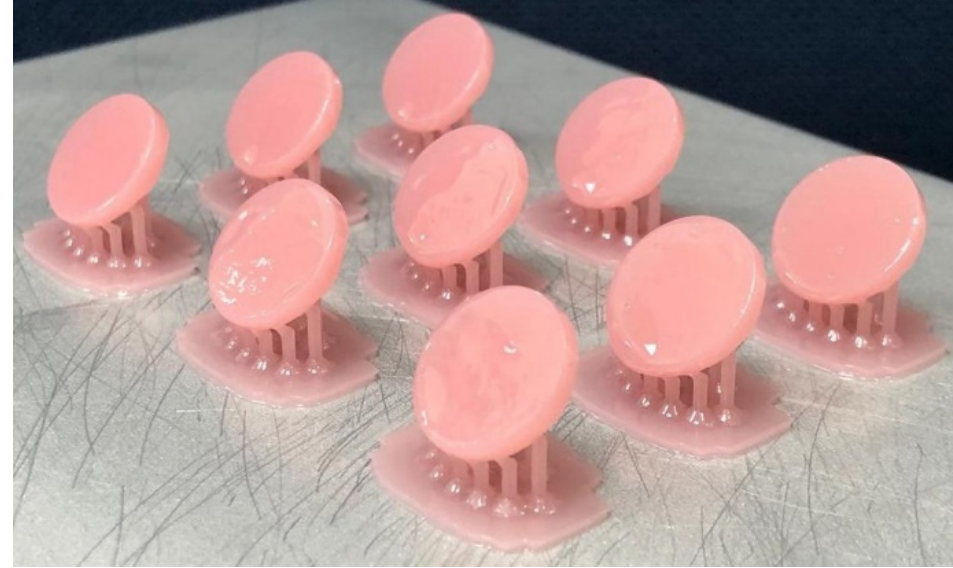
Figure 1. Specimens prepared by CAD/CAM additive manufacturing technique (3D printing).